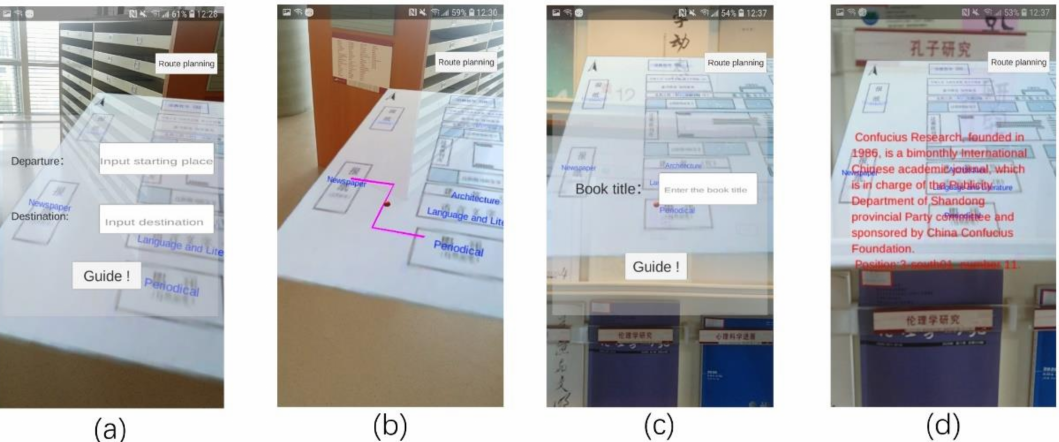
Figure 9. Interface collections of the proposed system in indoor navigation. ( a ) Navigation information input interface. ( b ) Navigation interface after route planning. ( c ) Enter the book title of the required bibliography. ( d ) Augmented reality information of the proposed system after arriving at the